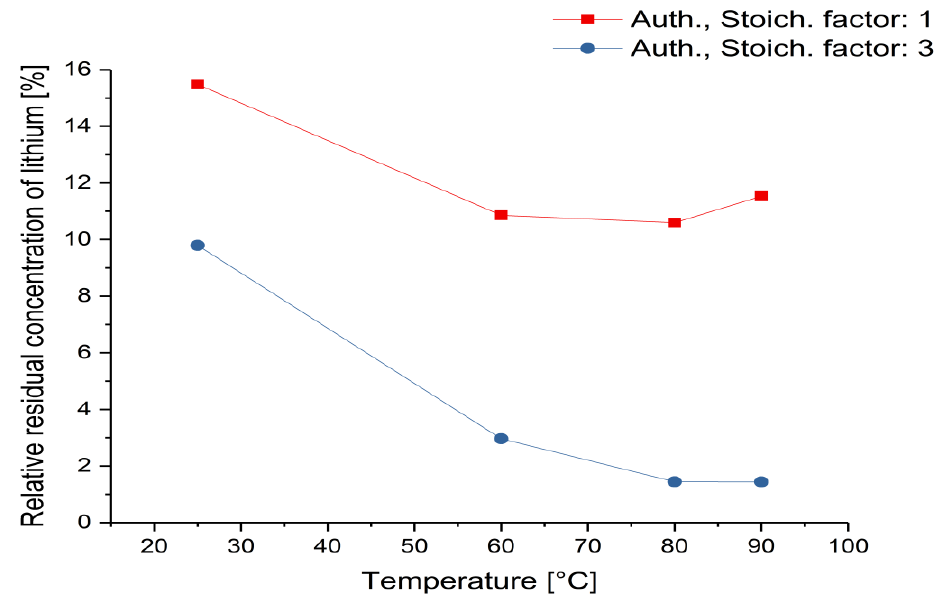
Figure 5. Relative residual concentration of lithium in the samples as a function of temperature and stoichiometric factor (interaction plot of the model) based on the authentic leaching solution for the precipitation with Na 3 PO 4 .